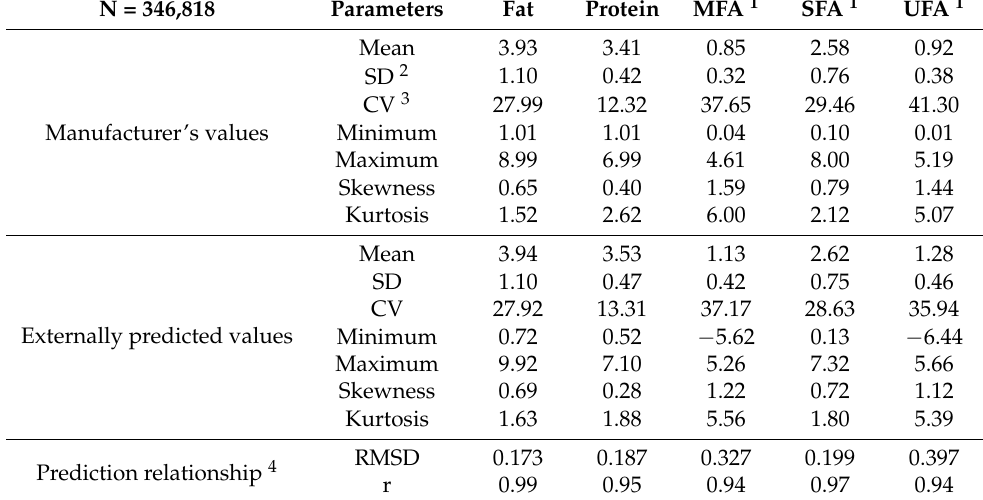
Table 2. Descriptive statistics of manufacturer’s and externally predicted phenotypes (g/dL of milk) and their relationships.